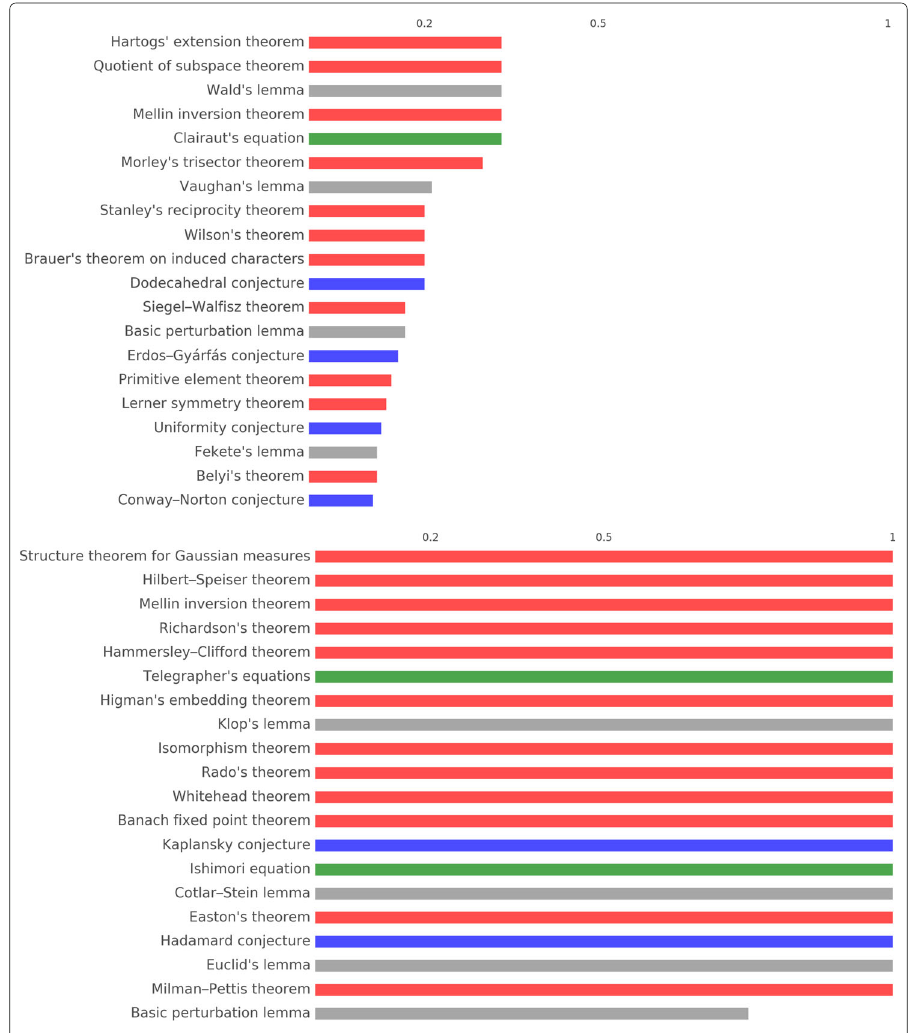
Fig. 12 Concept importance in S 2 stars 20 most important concepts appearing in the core (top) and the periphery (bottom) of S 2 stars. The bars reports the number of appearances in cores or peripheries divided by the number of appearance in edges and triangles